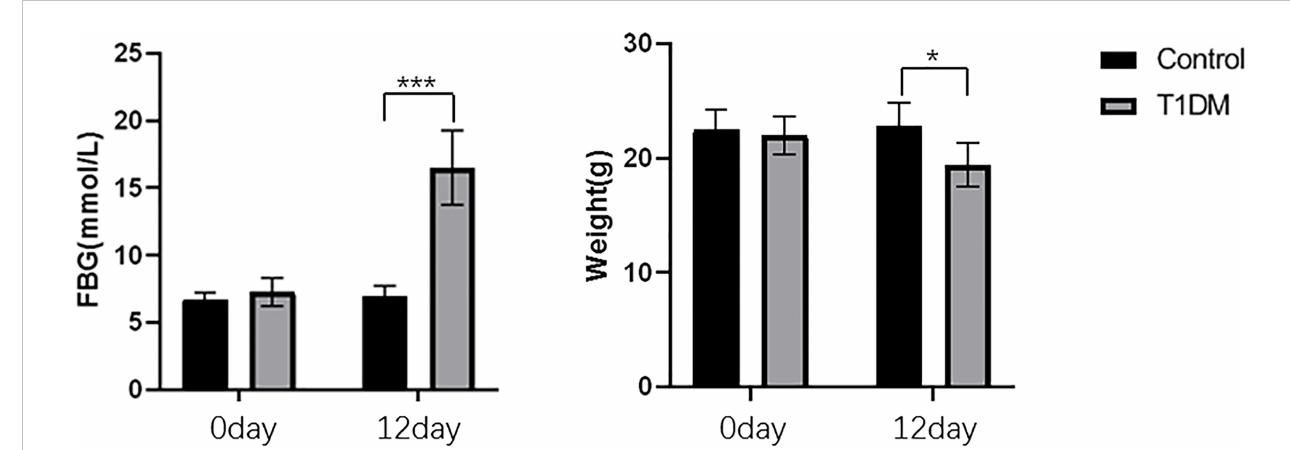
FIGURE 1 The changes of FBG and body weight in control and T1DM groups. Compared with the control group, the blood glucose was signi fi cantly increased, and the body weight was decreased in the T1DM group. *P < 0.05; ***P <